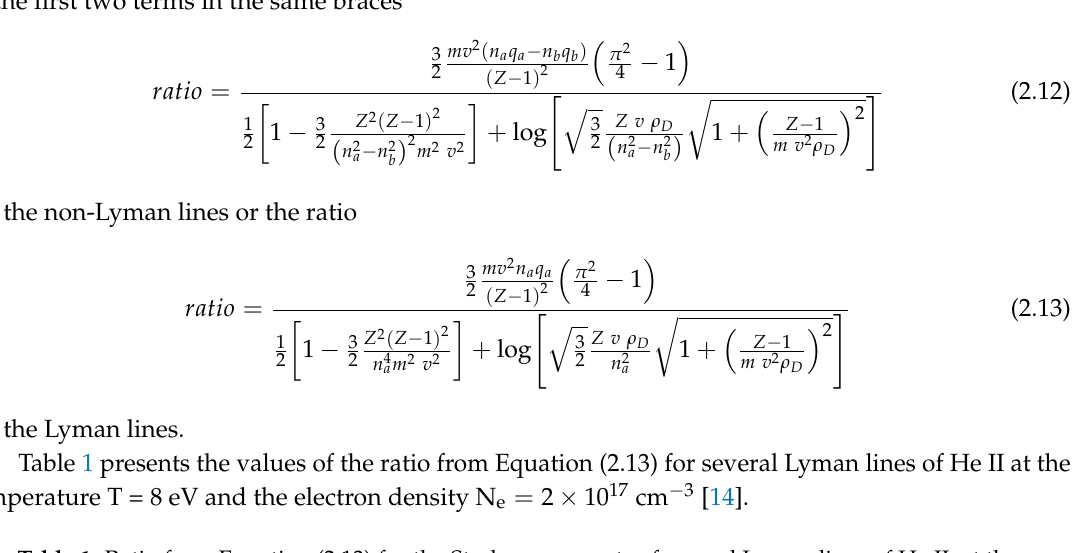
Table 1. Ratio from Equation (2.13) for the Stark components of several Lyman lines of He II. at the temperature T = 8 eV and the electron density N (cid:2915) = 2 × 10 (cid:2869)(cid:2875) cm − 3 [14].